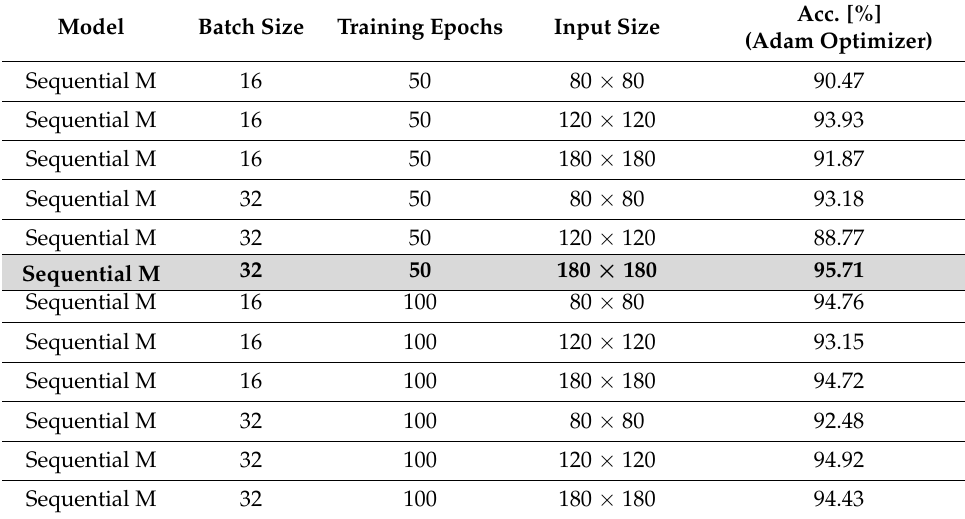
Table 3. Batch, Training Epochs, Input Size vs. Classification